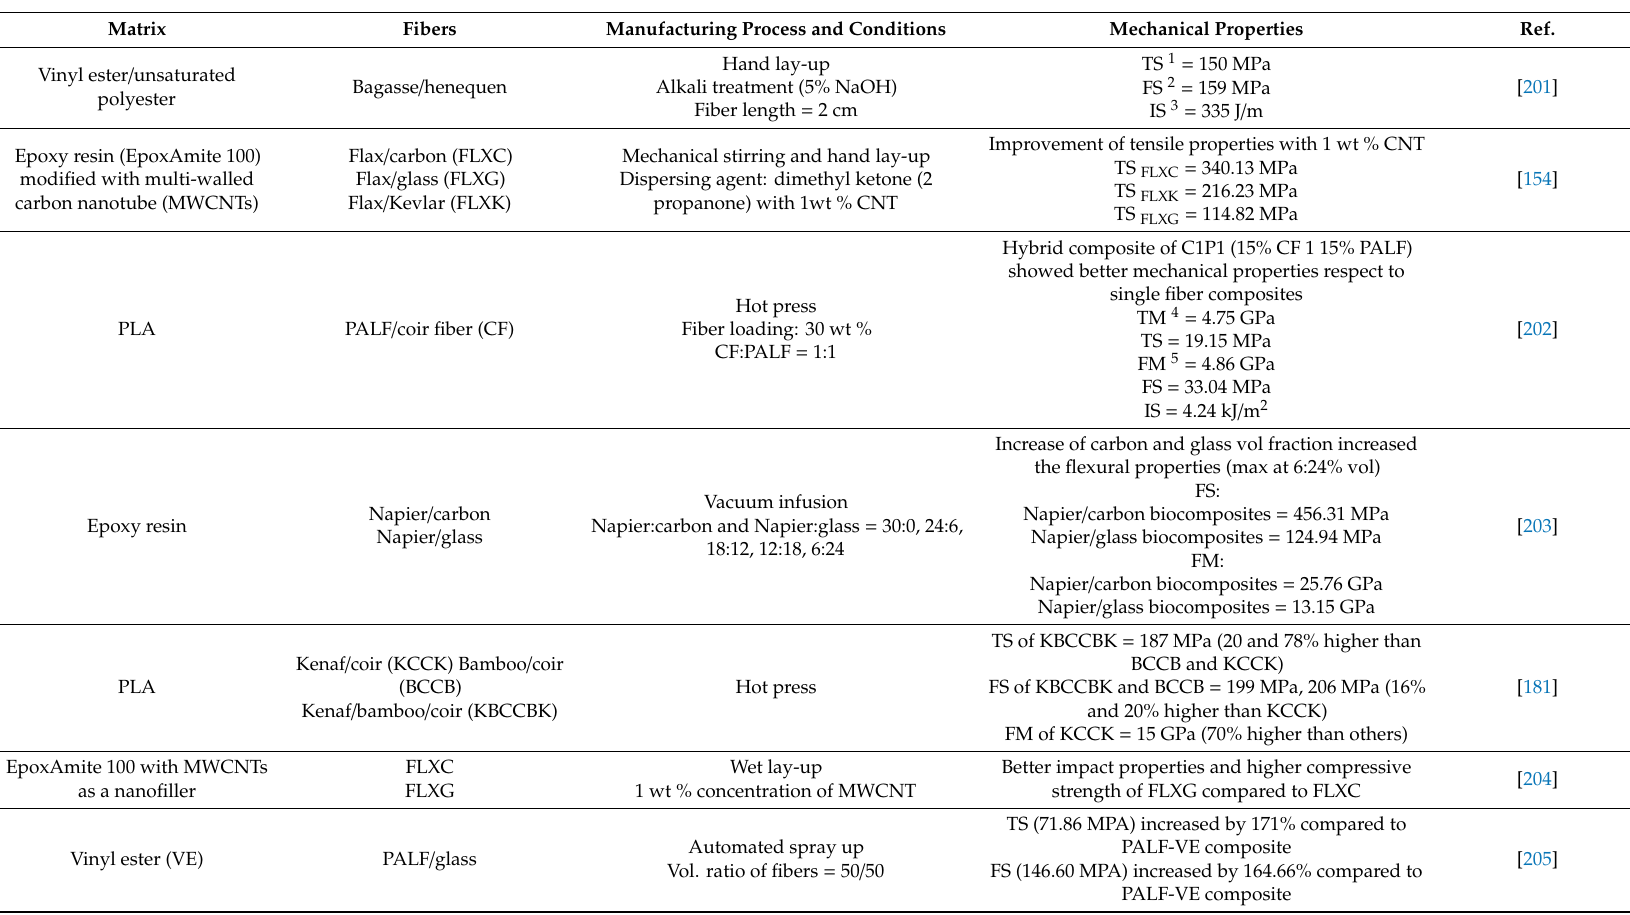
Table 6. Mechanical properties of recently developed hybrid